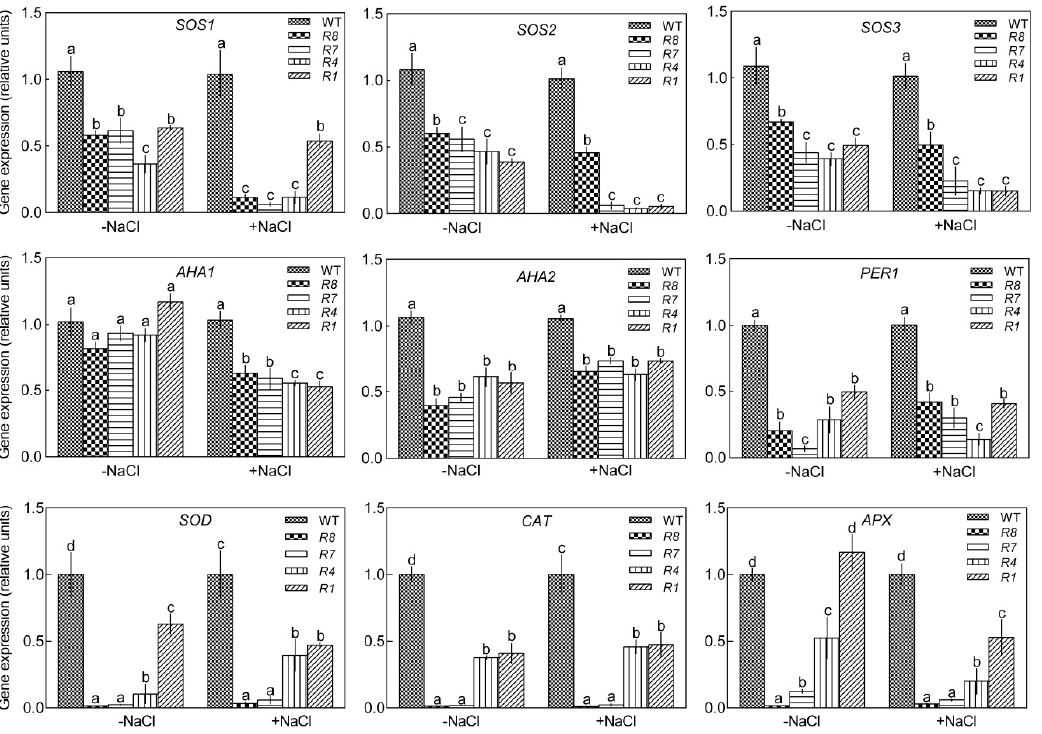
Figure 10. Changes in CPK12 expression alter expression of a subset of genes involved in salt stress responses. The mRNA levels in the seedling of wild-type GL1, CPK12 -RNAi mutants were determined by qRT-PCR. One-week-old seedlings were transferred to MS medium with and without the addition of 100 mM NaCl for ten days. The expression of salt stress responsive genes was analyzed. The gene expression levels were normalized relative to the value of the GL1 plants. Each value is the mean of the three independent determinations; columns labeled with letters in the same group indicate significant differences ( p < 0.05).